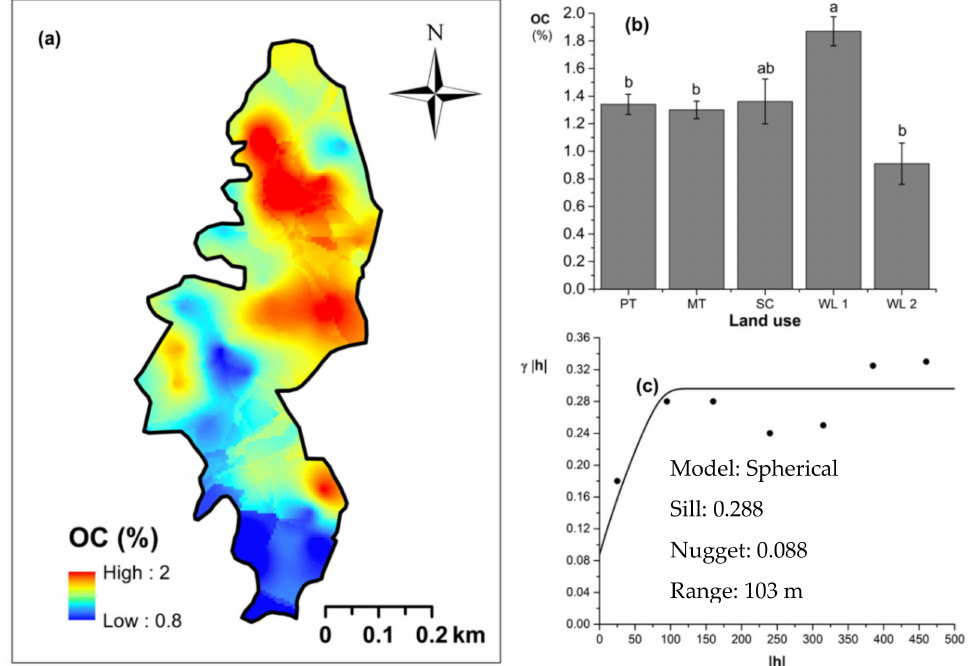
Figure 7. Spatial variability of soil organic carbon (OC): ( a ) map, ( b ) bar graph among different land uses (see Figure 1, label A for notations) in the Endane Biodiversity Corridor ( c ) variogram between lag distance and semivariance, and ( c ). Semivariance function: γ ( h ) = 0.088 + 0.003 h − 1.317 × 10 − 7 h 3 . Comparisons depicted by the different letters in the bars in subfigure (b) indicate significant pair-wise